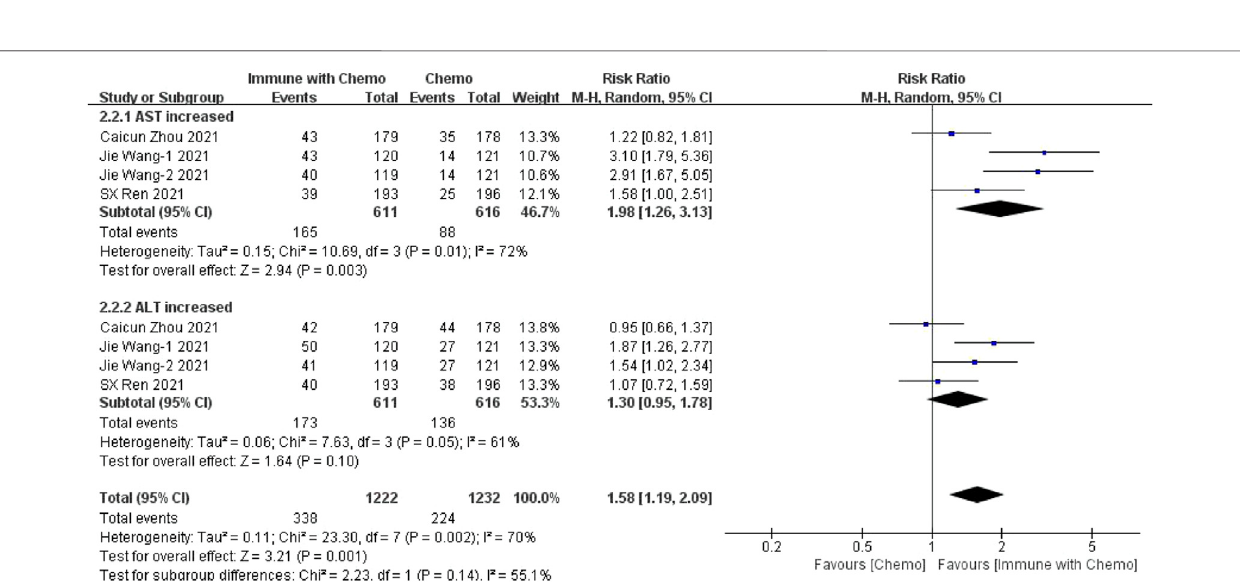
Frontiers in Pharmacology |